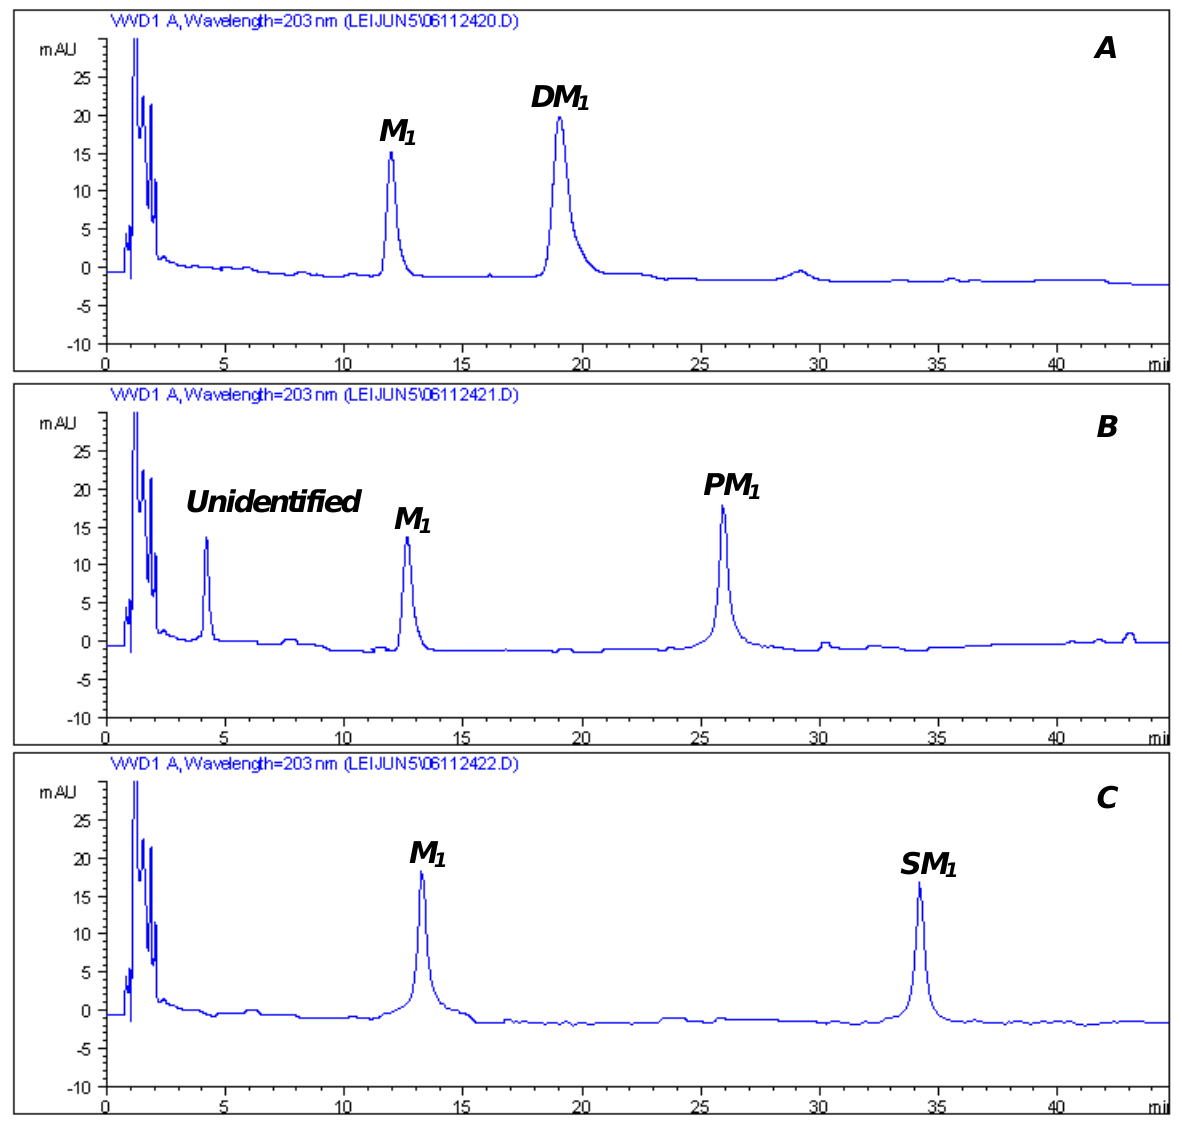
( 6 ), PM ( 7 ) and SM ( 8 ); A : M 1 1 1 1 reacted with 1